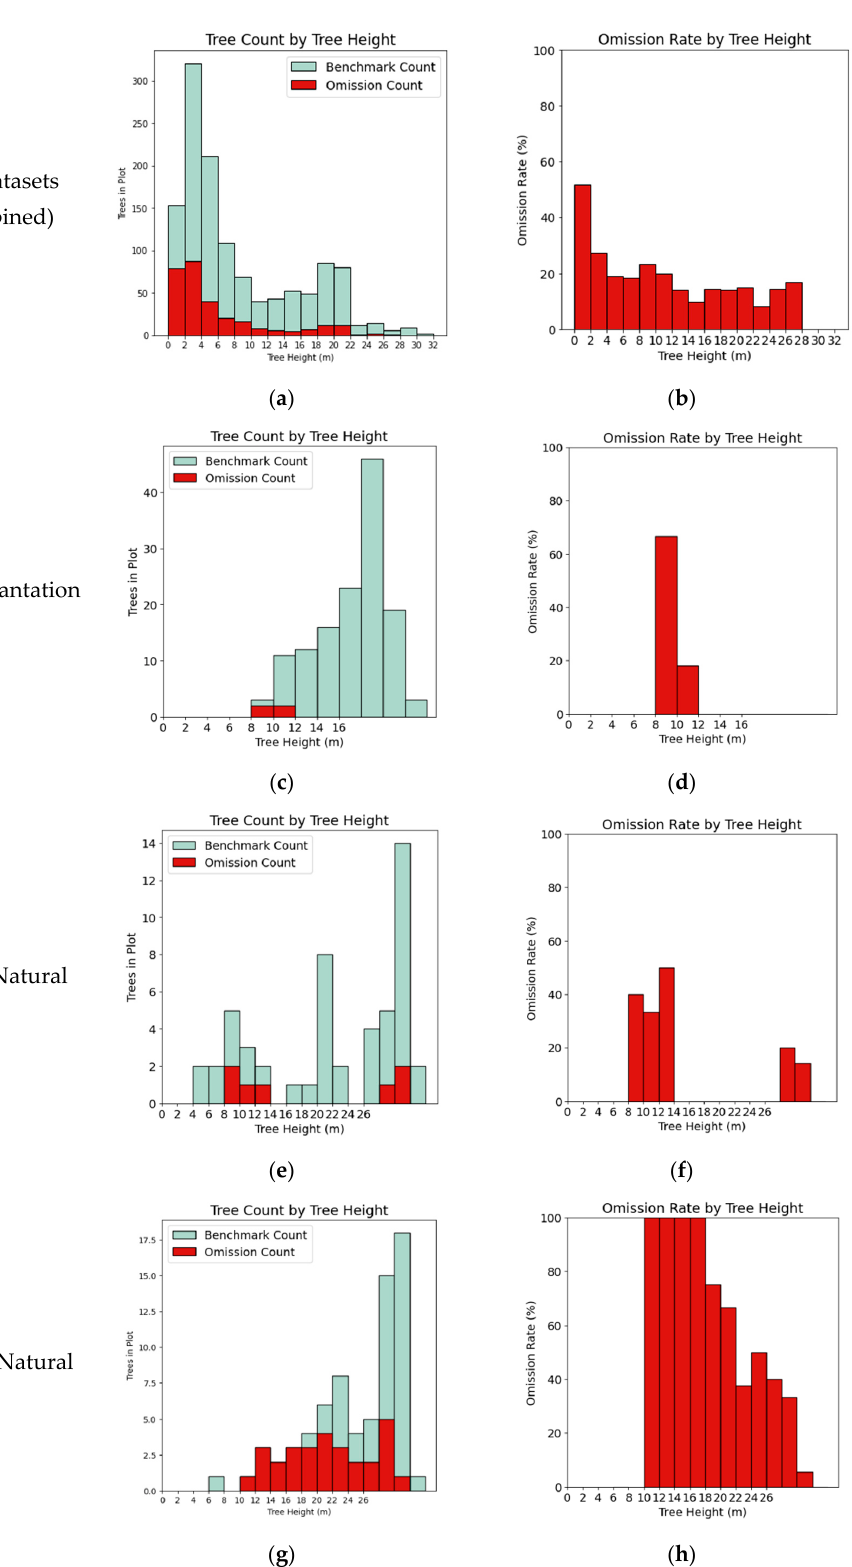
Figure 5. Omission errors are aggregated by tree height. ( a , c , e , g ) show the number of omissions by tree height superimposed on the number of trees in the validation data of the same height class. ( b , d , f , h ) show the omission errors as a percentage of total trees within each height